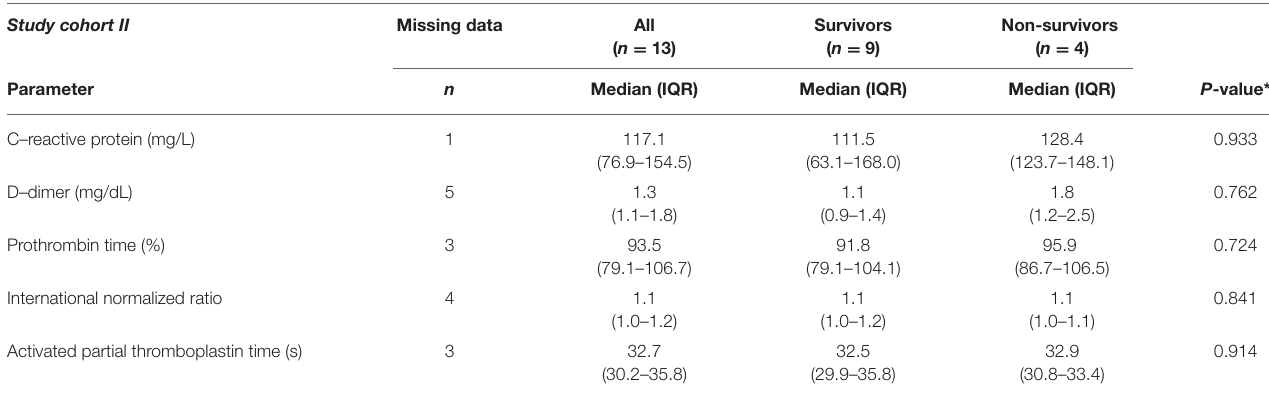
spot 403 ( Figure 3B ) and 413 ( Figure 3C ), which represent the two most abundant forms of this integrin ( Figure 3A ).